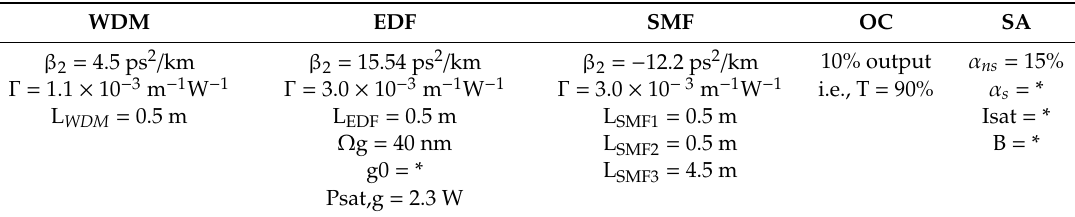
Table 1. Constant and variable parameters in the simulation.